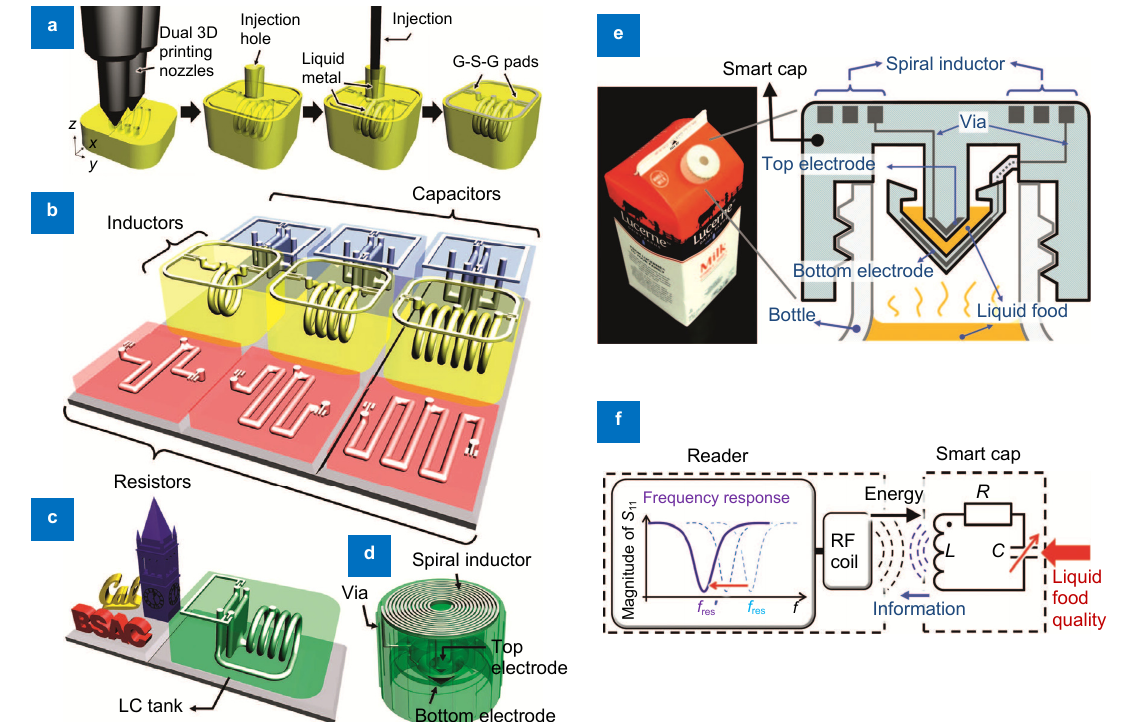
Fig. 5 | Fabrication process of 3D “smart cap” with an embedded inductor–a wireless passive sensor 12 . ( a ) 3D fabrication process with embedded and electrically conductive structures. ( b ) 3D microelectronics components, including parallel-plate capacitors, solenoid-type inductors, and meandering-shape resistors. ( c ) A 3D LC tank, which is formed by combining a solenoid-type inductor and a parallel-plate capacitor. ( d ) A wireless passive sensor demonstration of a “smart cap”, containing the 3D-printed LC-resonant circuit. ( e ) A smart cap with a half-gallon milk package, and the cross-sectional schematic diagram. (f) Sensing principle with the equivalent circuit